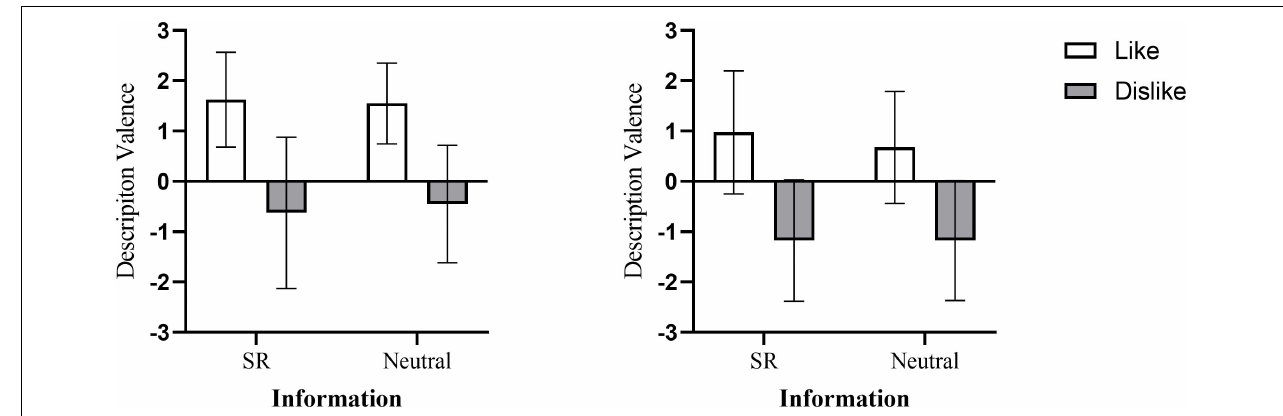
FIGURE 2 | Description valence as a function of the audience’s attitude and the information under high relational motivation condition ( left panel ) and under low relational motivation condition ( right panel ) (bars represent 95% confidence intervals).